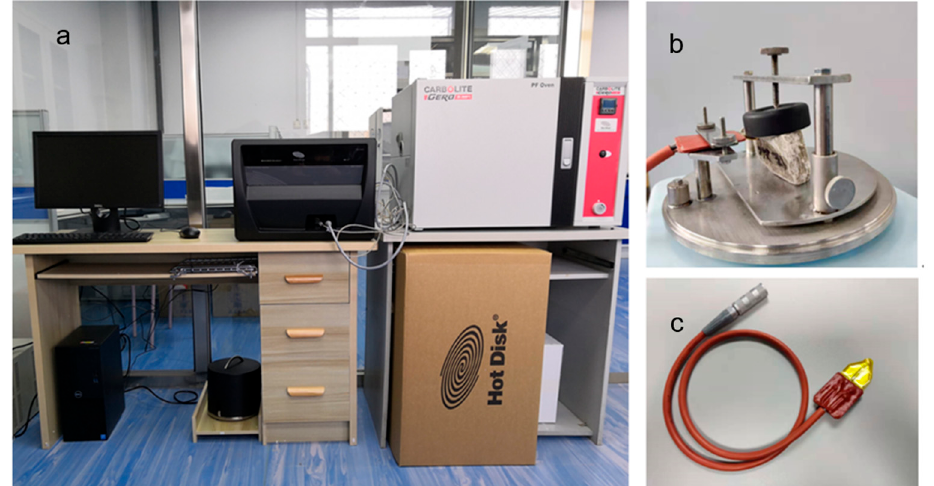
Figure 10. Schematic diagram of the thermal conductivity measurement principle: ( a ) Hot disk analyzer and the operating platform; ( b ) Testing of the rock samples according to the transient flat heat source method; ( c ) Thin-layer, disc-shaped